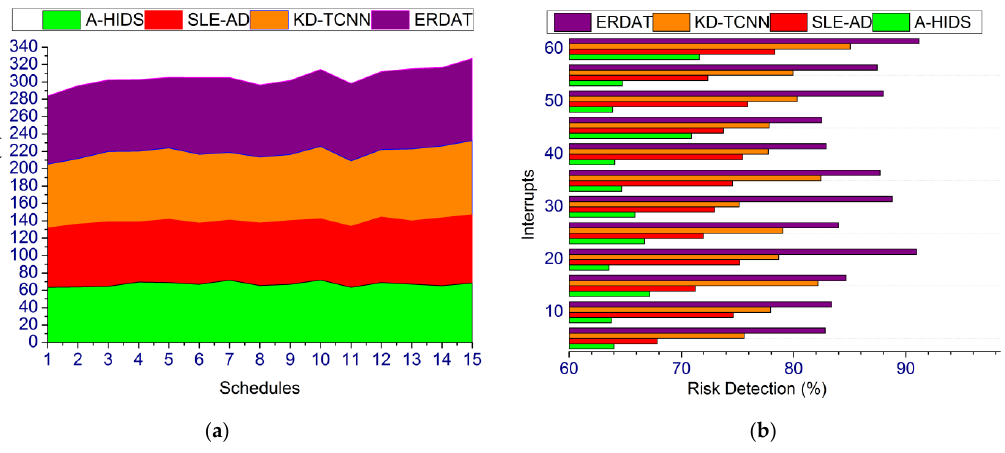
Figure 9. Risk Detection. ( a ) Risk Detection. ( b ) Interupts.